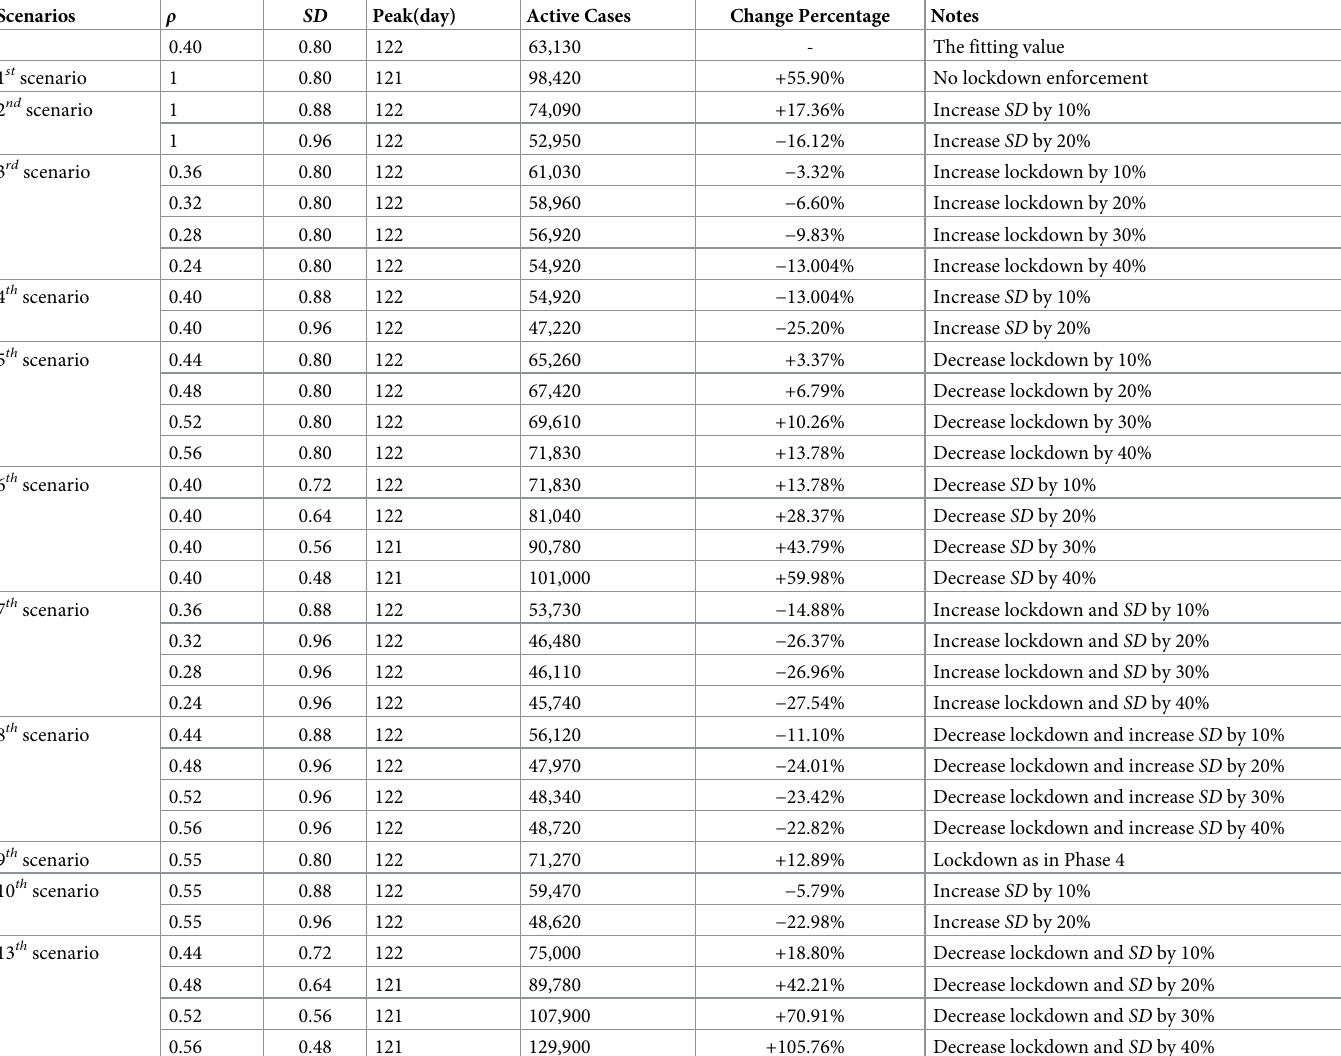
Table 9. Results of different scenarios for Phase